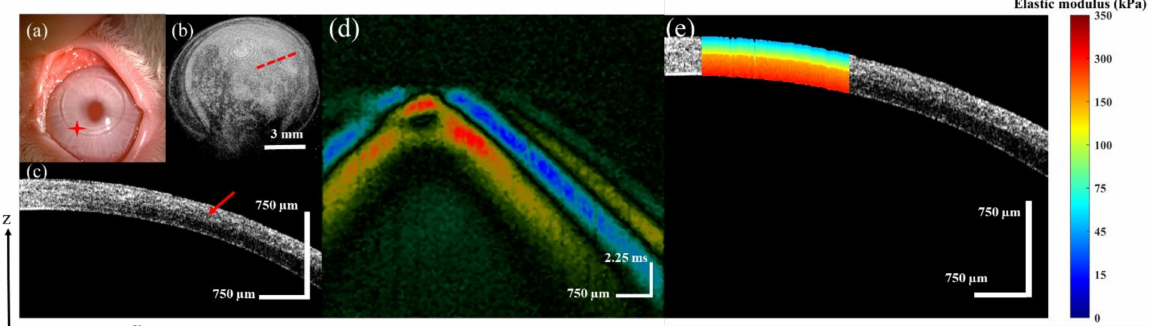
Figure 5. The FLEx surgery corneal images, ( a ) is the FLEx surgery surface morphology, ( b ) is the 3D reconstruction structure, ( c ) is the 2D tomography, ( d ) is the spatial-temporal displacement diagram of the Lamb wave, ( e ) is depth-resolved elastography result of the cornea.